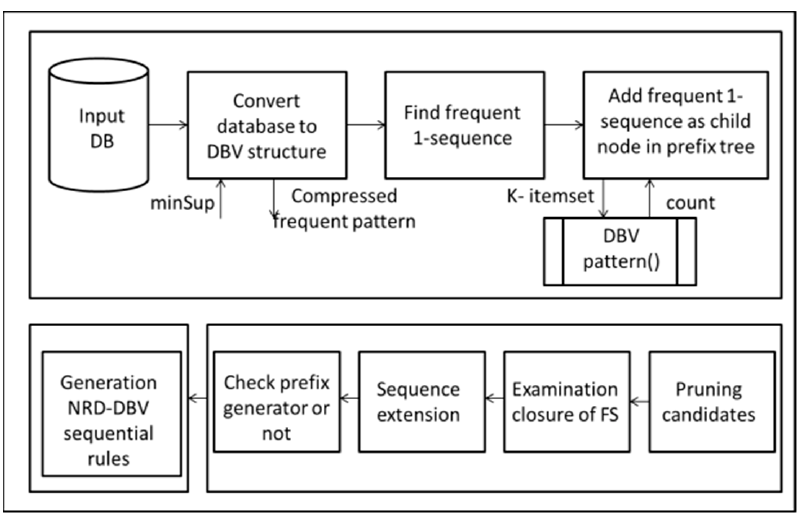
Figure 3. The NRD-DBV algorithm framework based on [31].